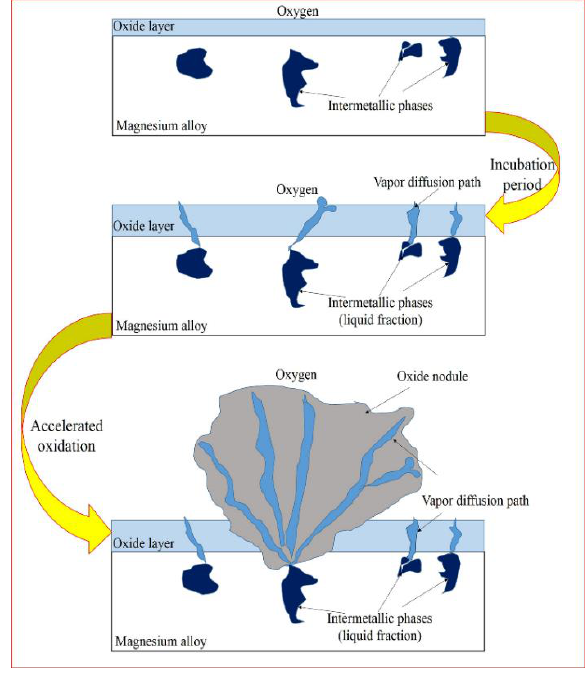
Figure 11. The schematic representation of the evolution of alloy oxidation. A hypothesis for the evolution of alloy